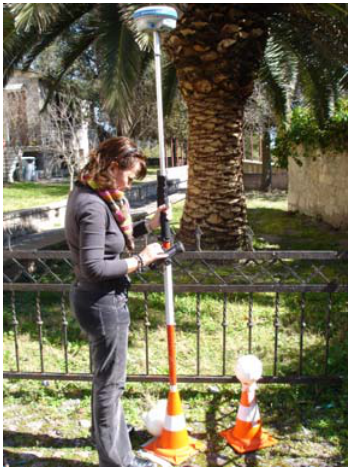
Fig. 14: GPS survey to georeference